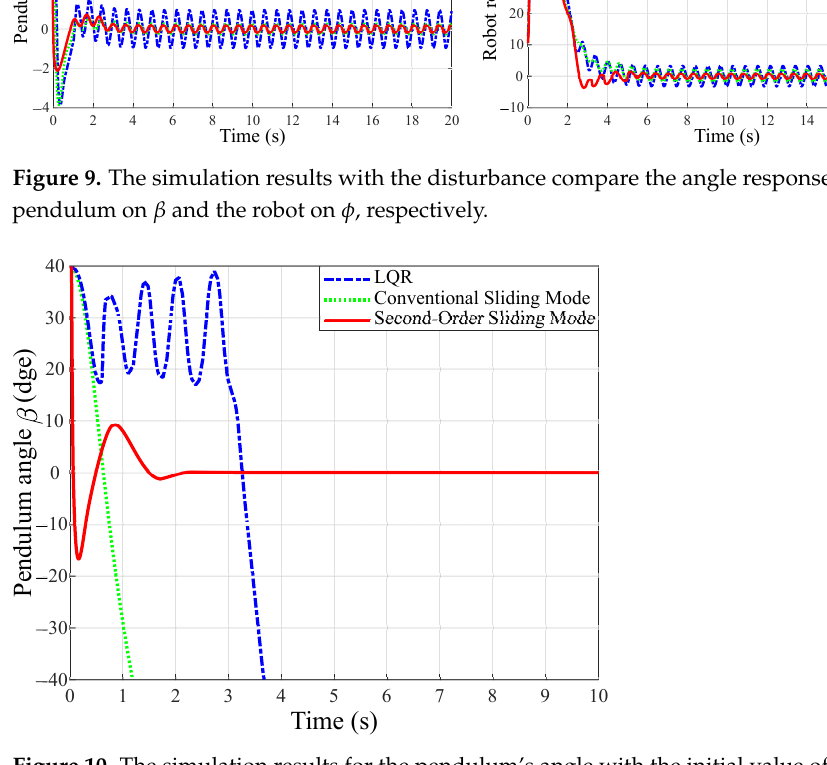
Figure 10. The simulation results for the pendulum’s angle with the initial value of 40 ◦ compare the angle responses of the inverted pendulum on β